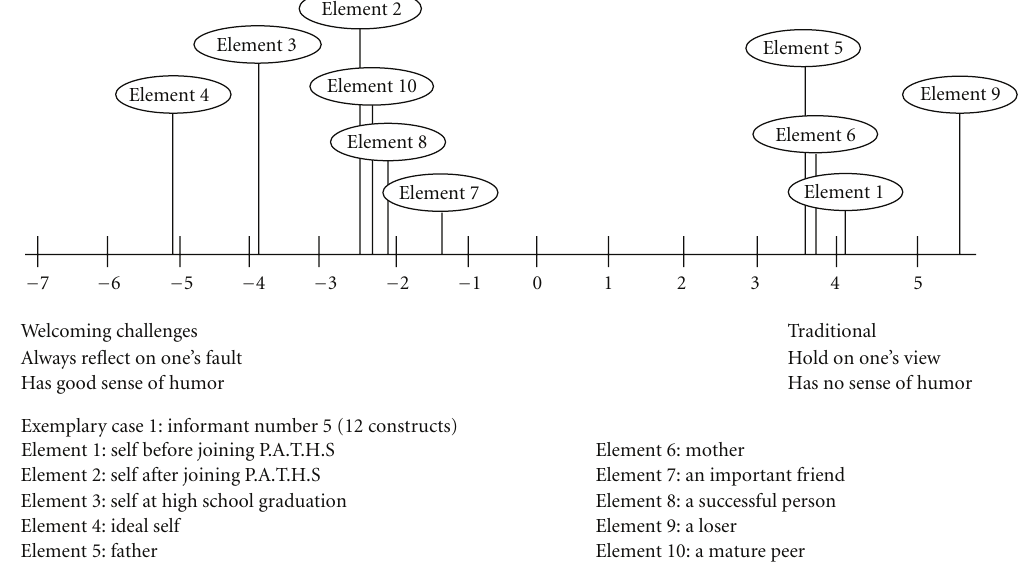
Figure 1: Line graph showing the mental representation of di ff erent roles for case